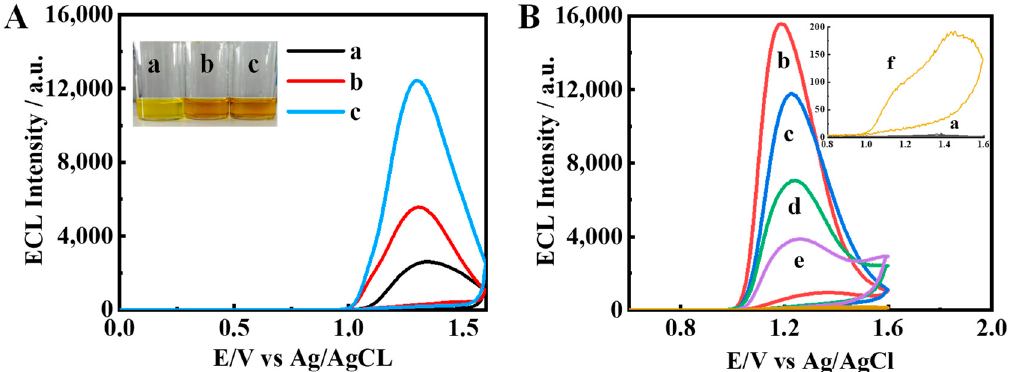
Figure 2. Comparison of ECL signals of ( A ) a: Ir complexes monomer (black), b: Ir/NCDs (red), and c: Ir–NCDs (blue); and ( B ) a: bare GCE; b: Ir–NCDs/PDDA; c: Ir–NCDs/PDDA/GA; d: Ir–NCDs/PDDA/GA/Ab; e: Ir–NCDs/PDDA/GA/Ab/BSA; f: Ir–NCDs/PDDA/GA/Ab/BSA/SE.